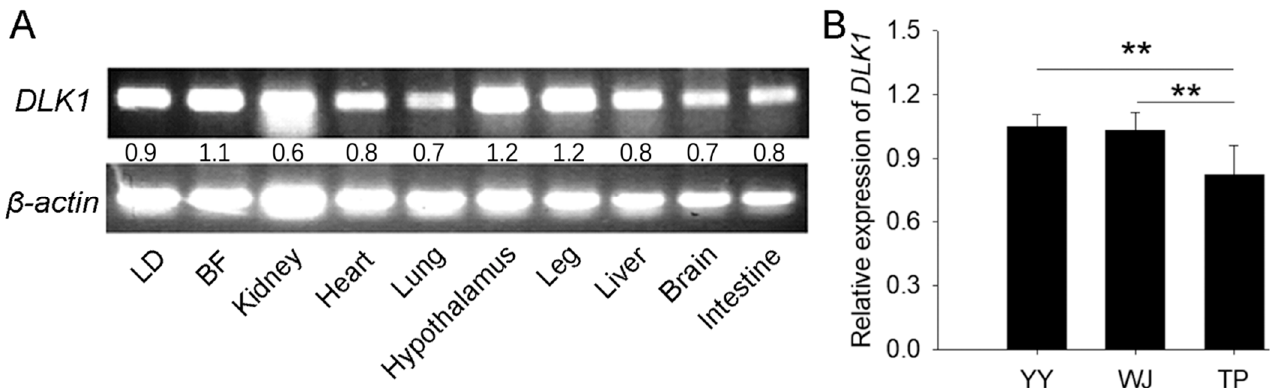
Figure 1. Expressions of DLK1 in the embryonic tissues of pigs. ( A ) DLK1 expression in the different tissues of TP pigs at the embryonic stage by SqRT-PCR. LD, longissimus dorsi ; BF, back fat; ( B ) the mRNA expression levels of DLK1 in the LD of three pig breeds. YY, Yorkshire ( n = 6); WJ, Wujin pig ( n = 6); TP, Tibetan pig ( n = 6). Each bar represents the mean ± SD. ** p < 0.01.